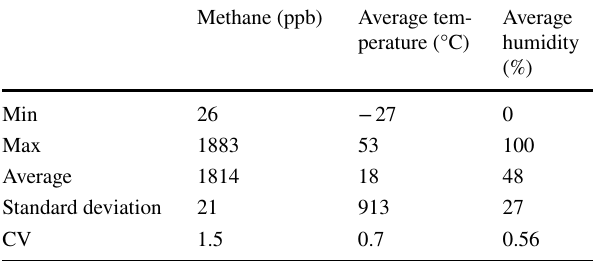
Table 1 Statistical analysis of